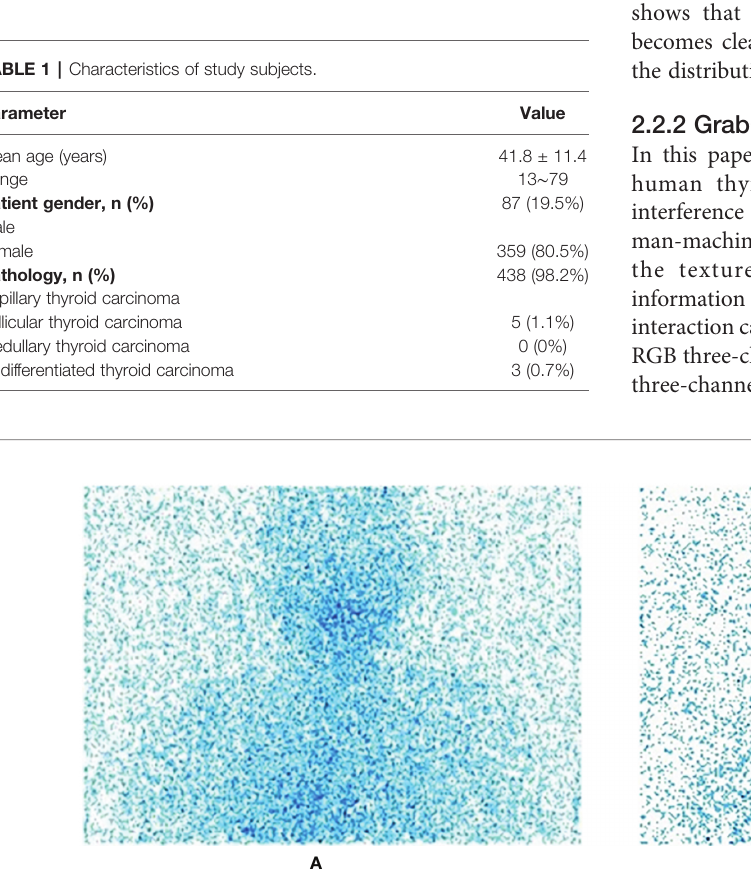
FIGURE 1 | (A) the original SPECT image with residue; (B) the original SPECT image without